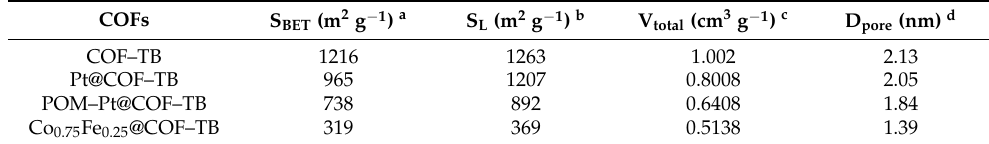
Table 1. Porosity data of prepared porous materials.